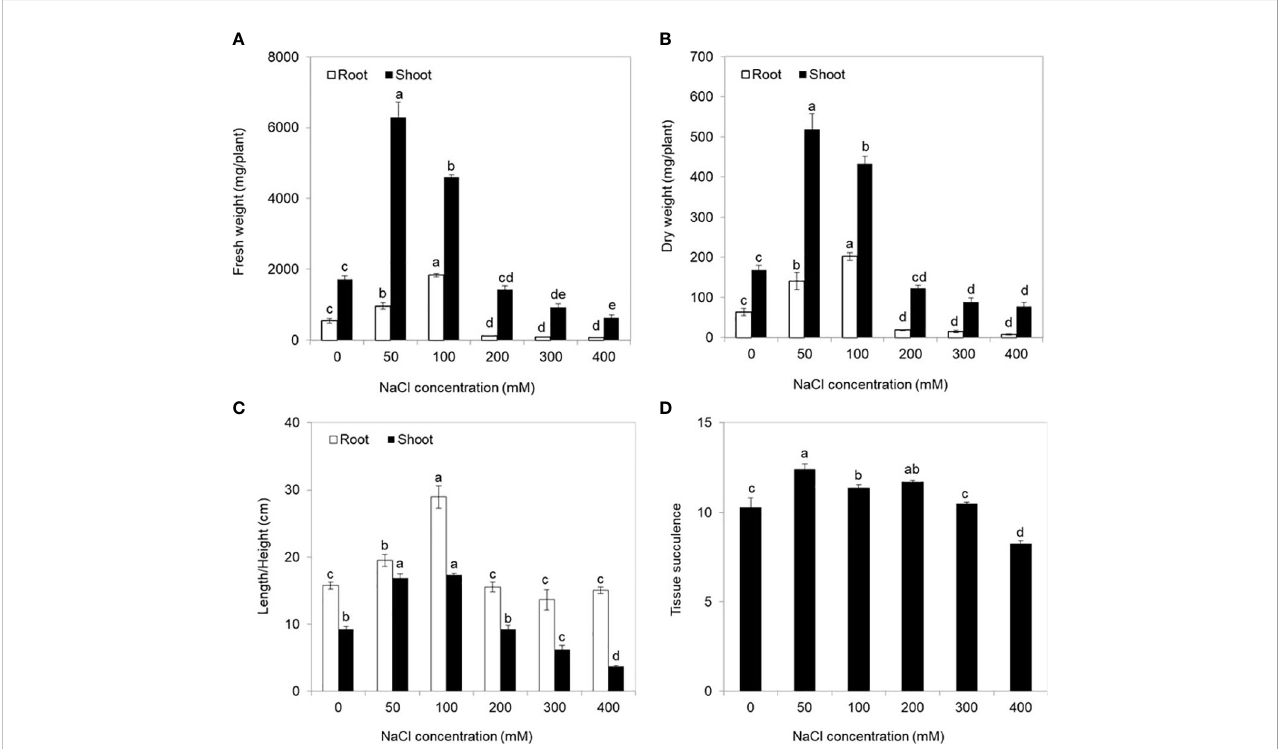
FIGURE 2 Physiological indices of Salicornia europaea seedlings exposed to different levels of salt stress for 30 days. (A) Fresh weight, (B) dry weight, (C) length/ height, and (D) tissue succulence. Values are the means ± standard errors (SE) ( n = 4), and bars indicate SE. Signi fi cant differences between columns in the roots and shoots are indicated by different lowercase letters (Duncan ’ s test, p <